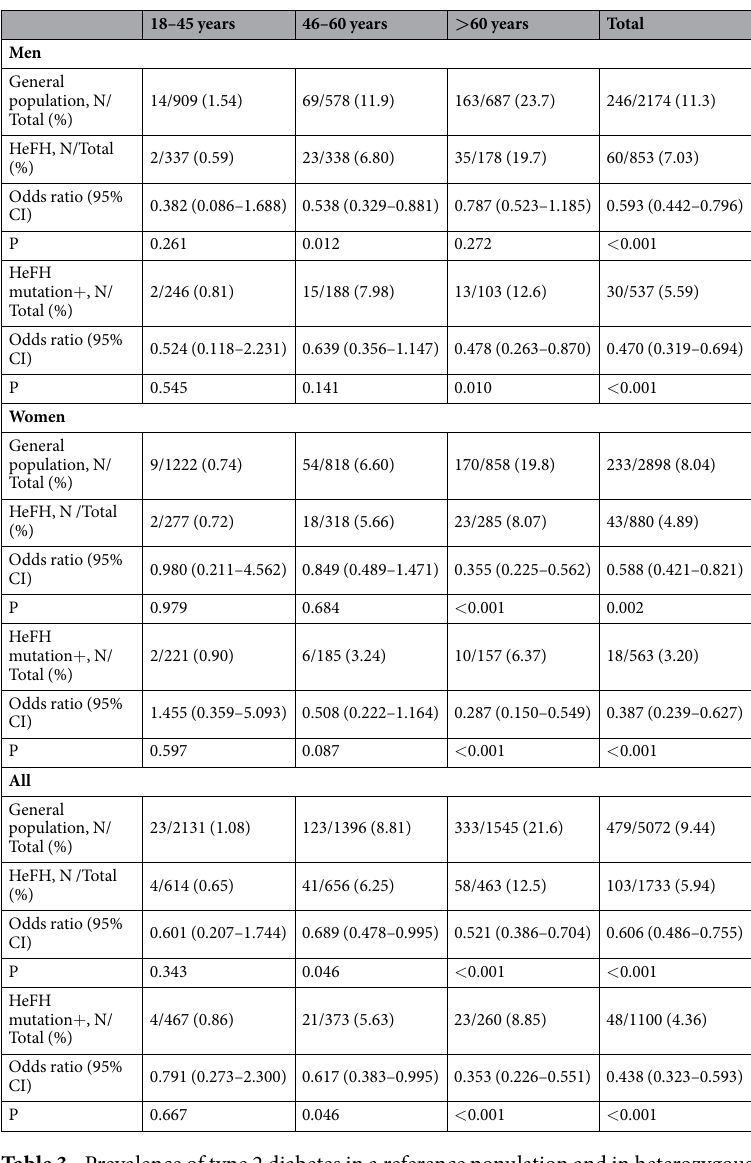
Table 3. Prevalence of type 2 diabetes in a reference population and in heterozygous familial hypercholesterolemia patients by sex and